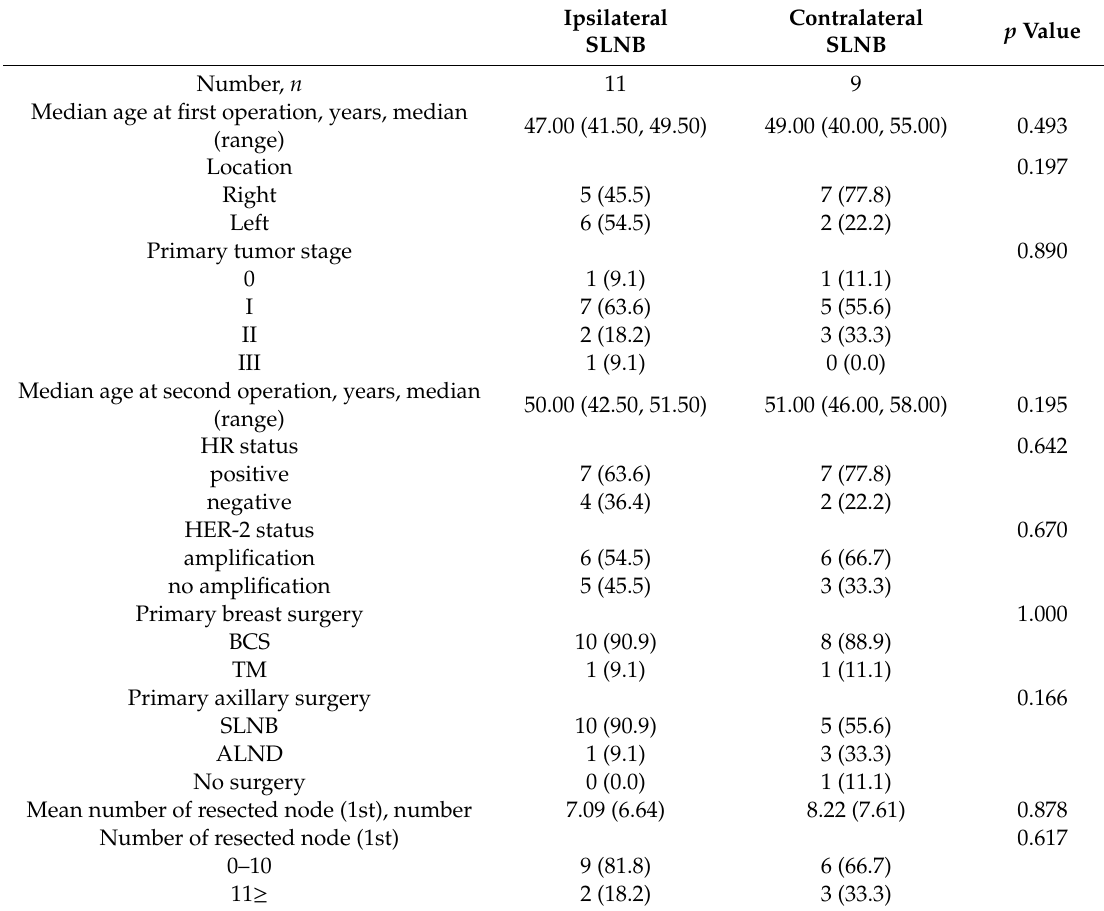
Table 1. Basic characteristics of ipsilateral and contralateral Sentinel lymph node biopsy (SLNB) group. Ipsilateral Contralateral SLNB p value SLNB Number, n 11 9 Median age at first operation, years, median (range) 47.00 (41.50, 49.50)